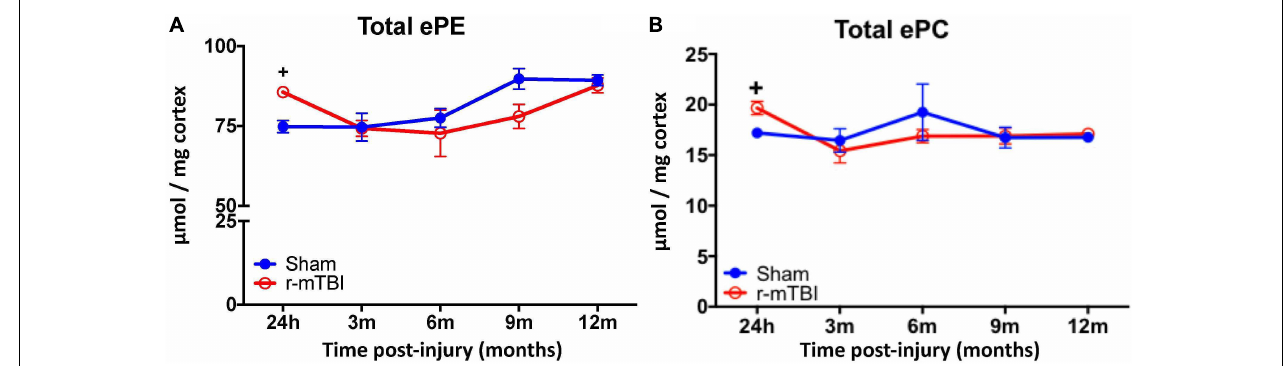
FIGURE 3 | Total ether PE and ether PC levels in the cortex of repetitive-mTBI hTau mice. Significant changes in total etherPE (A) and etherPC (B) lipid species in the cortex of a model of repetitive-mTBI in hTau mice. Sample size for all groups across all time points is n = 4. All data represent mean µ M per (10 mg) wet weight ± SEM. Individual molecular lipid species were quantified by liquid chromatography/mass spectrometry and were summed after LipidomeDB analyses to generate total etherphospholipid levels. Asterisks represent + P < 0.05 for comparisons between sham/r-mTBI mice. ePE, etherphosphatidylethanolamine; ePC,